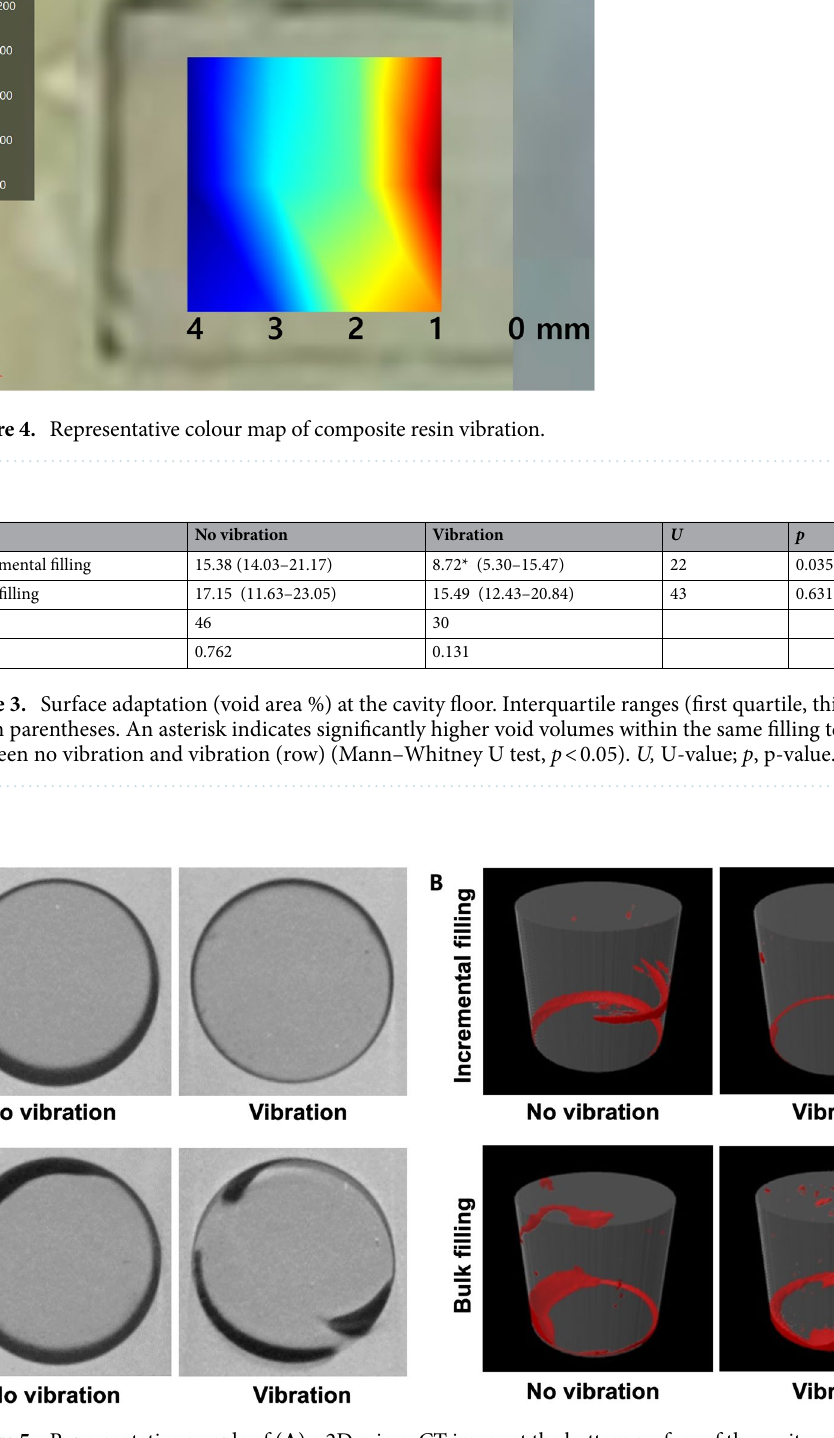
Figure 5. Representative sample of ( A ) a 2D micro-CT image at the bottom surface of the cavity and ( B ) a 3D rendering image of each